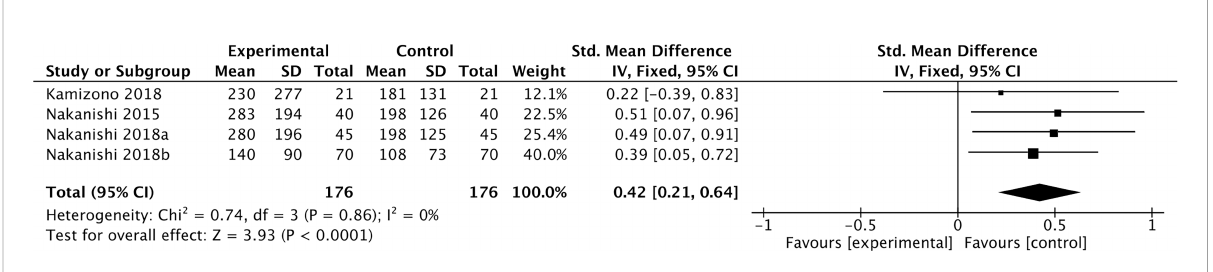
FIGURE 2 Forest plot of cFGF21 concentration in individuals with or without smoking. Fixed effect models were used as the pooling method. The mean value refers to the mean cFGF21 concentration in each group. cFGF21, circulating fi broblast growth factor